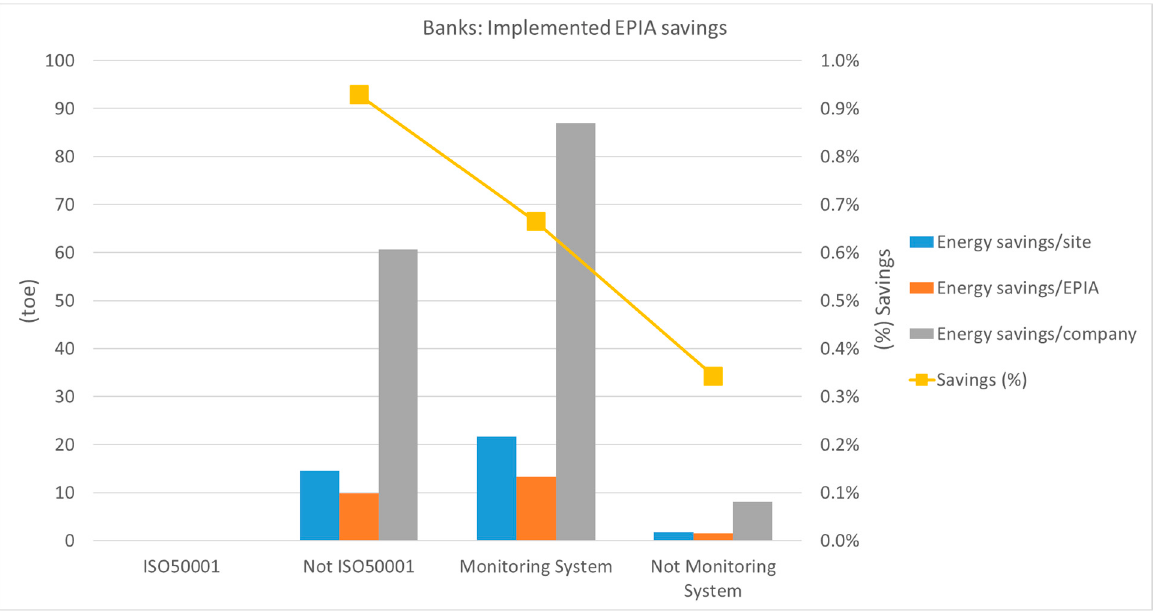
Figure 8. Banks: implemented EPIA savings.